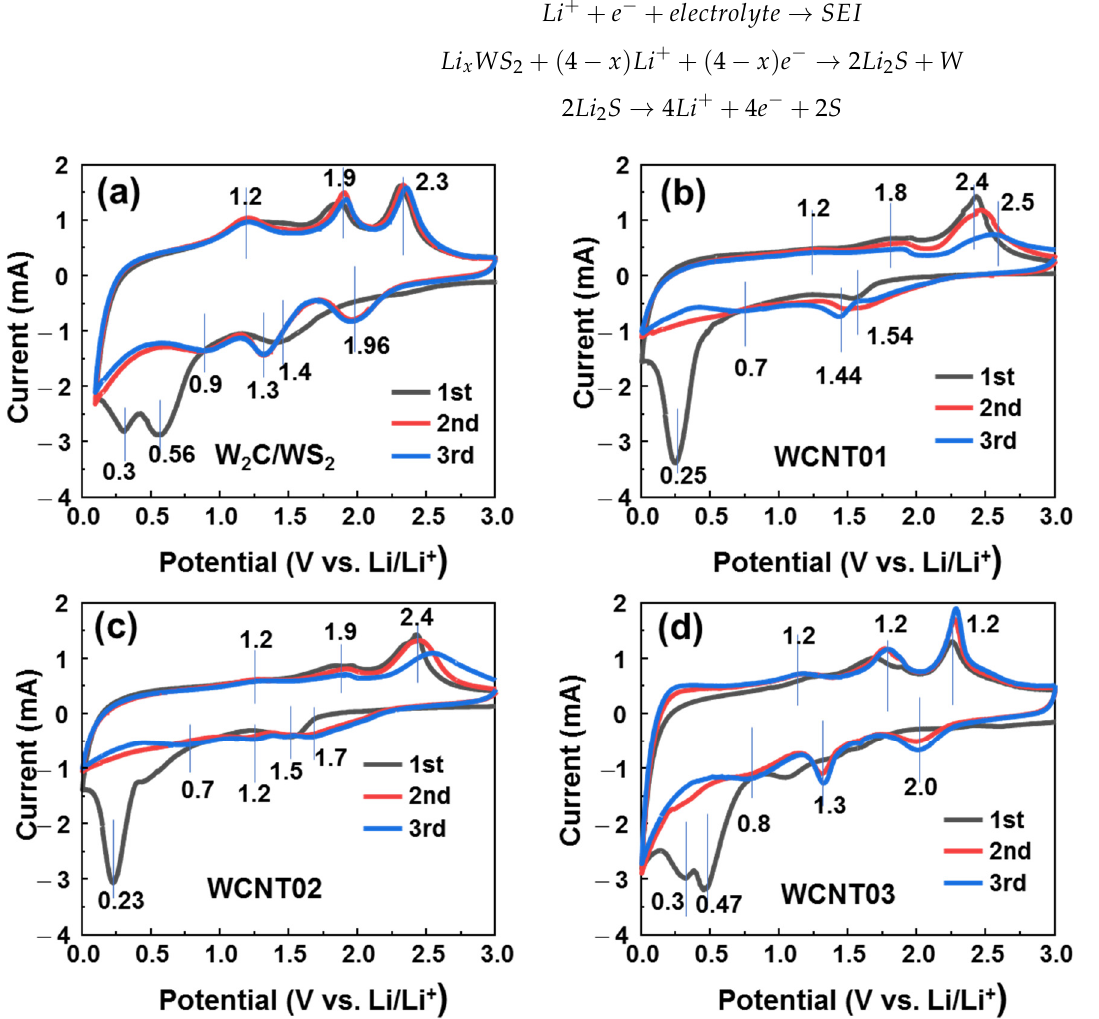
Figure 4. Cyclic voltammograms of the ( a ) W 2 C / WS 2 , ( b ) WCNT01, ( c ) WCNT02, and ( d ) WCNT03 anodes.